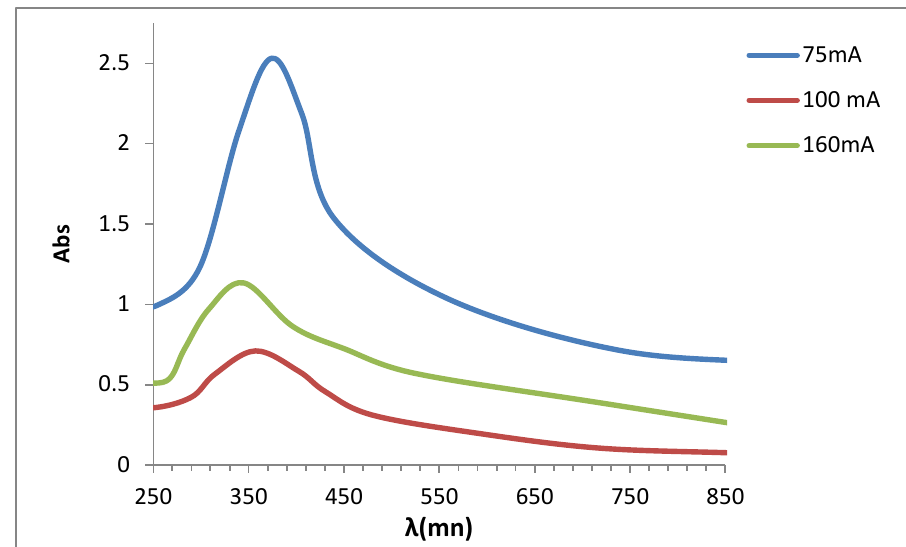
Fig. 3: Absorbance within UV visible for FeCoSb alloy nanofluid from alloy wire with 0.3mm diameter in DDDW at three different values of current.